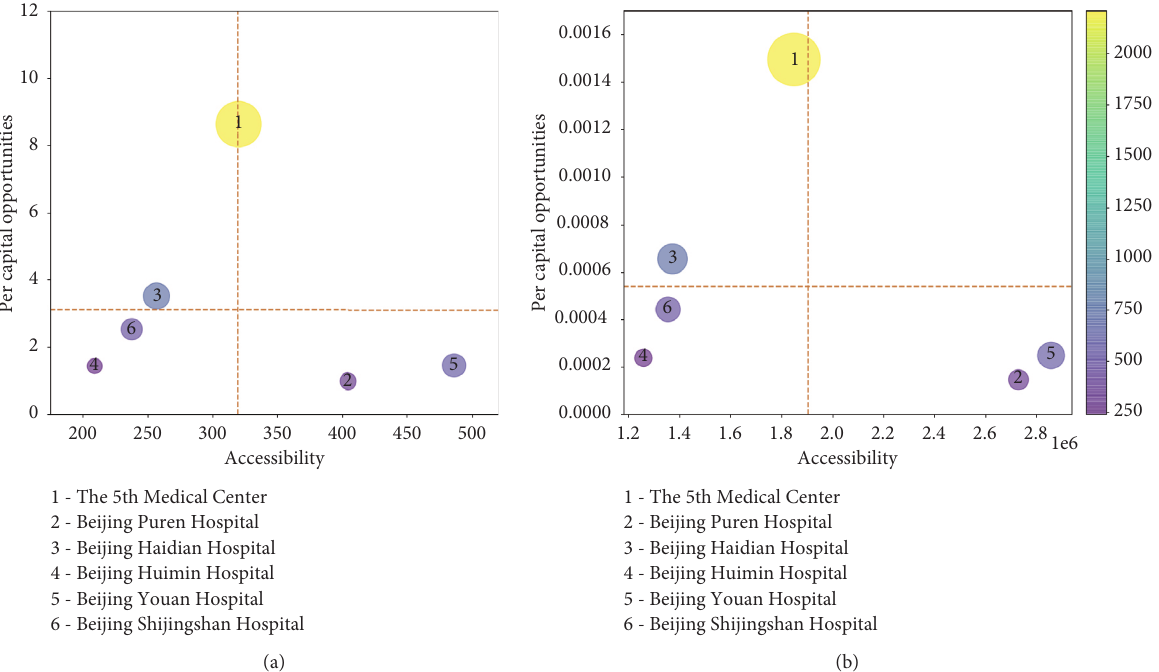
Figure 14: Accessibility and per capita opportunities of the designated hospitals: (a) without considering population variation and calculated on equation (4); (b) considering population variation and calculated on equation (6). The yellow dotted line indicates the mean value of accessibility and per capita opportunities separately and the size of point is the medical capacity of each hospital.